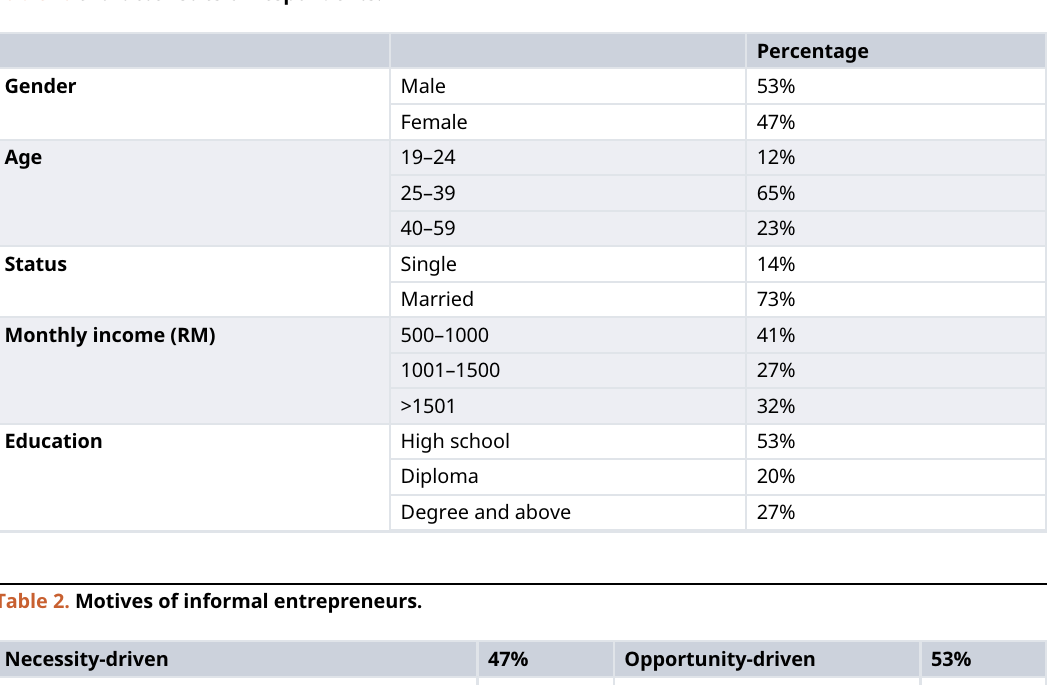
Table 1. Characteristics of